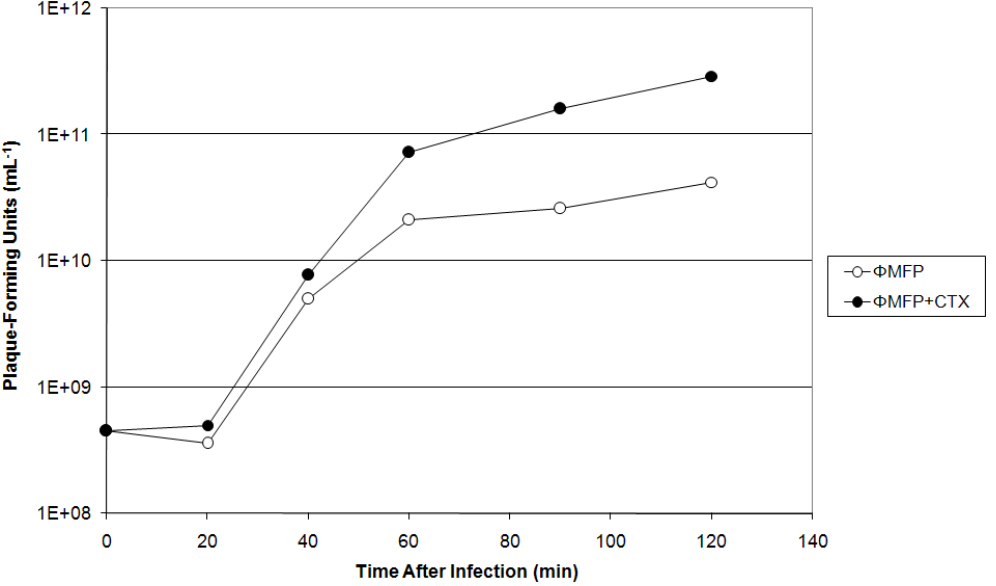
Figure 3. Increase in phage titer in the presence of the cephalosporin cefotaxime (CTX). E. coli strain MFP was infected with phage w MFP in Luria liquid medium supplemented at the time of infection with 20 ng/mL of cefotaxime, or left untreated. The multiplicity of infection was , 5. Chloroform was added at various times after infection to lyse the infected cells.